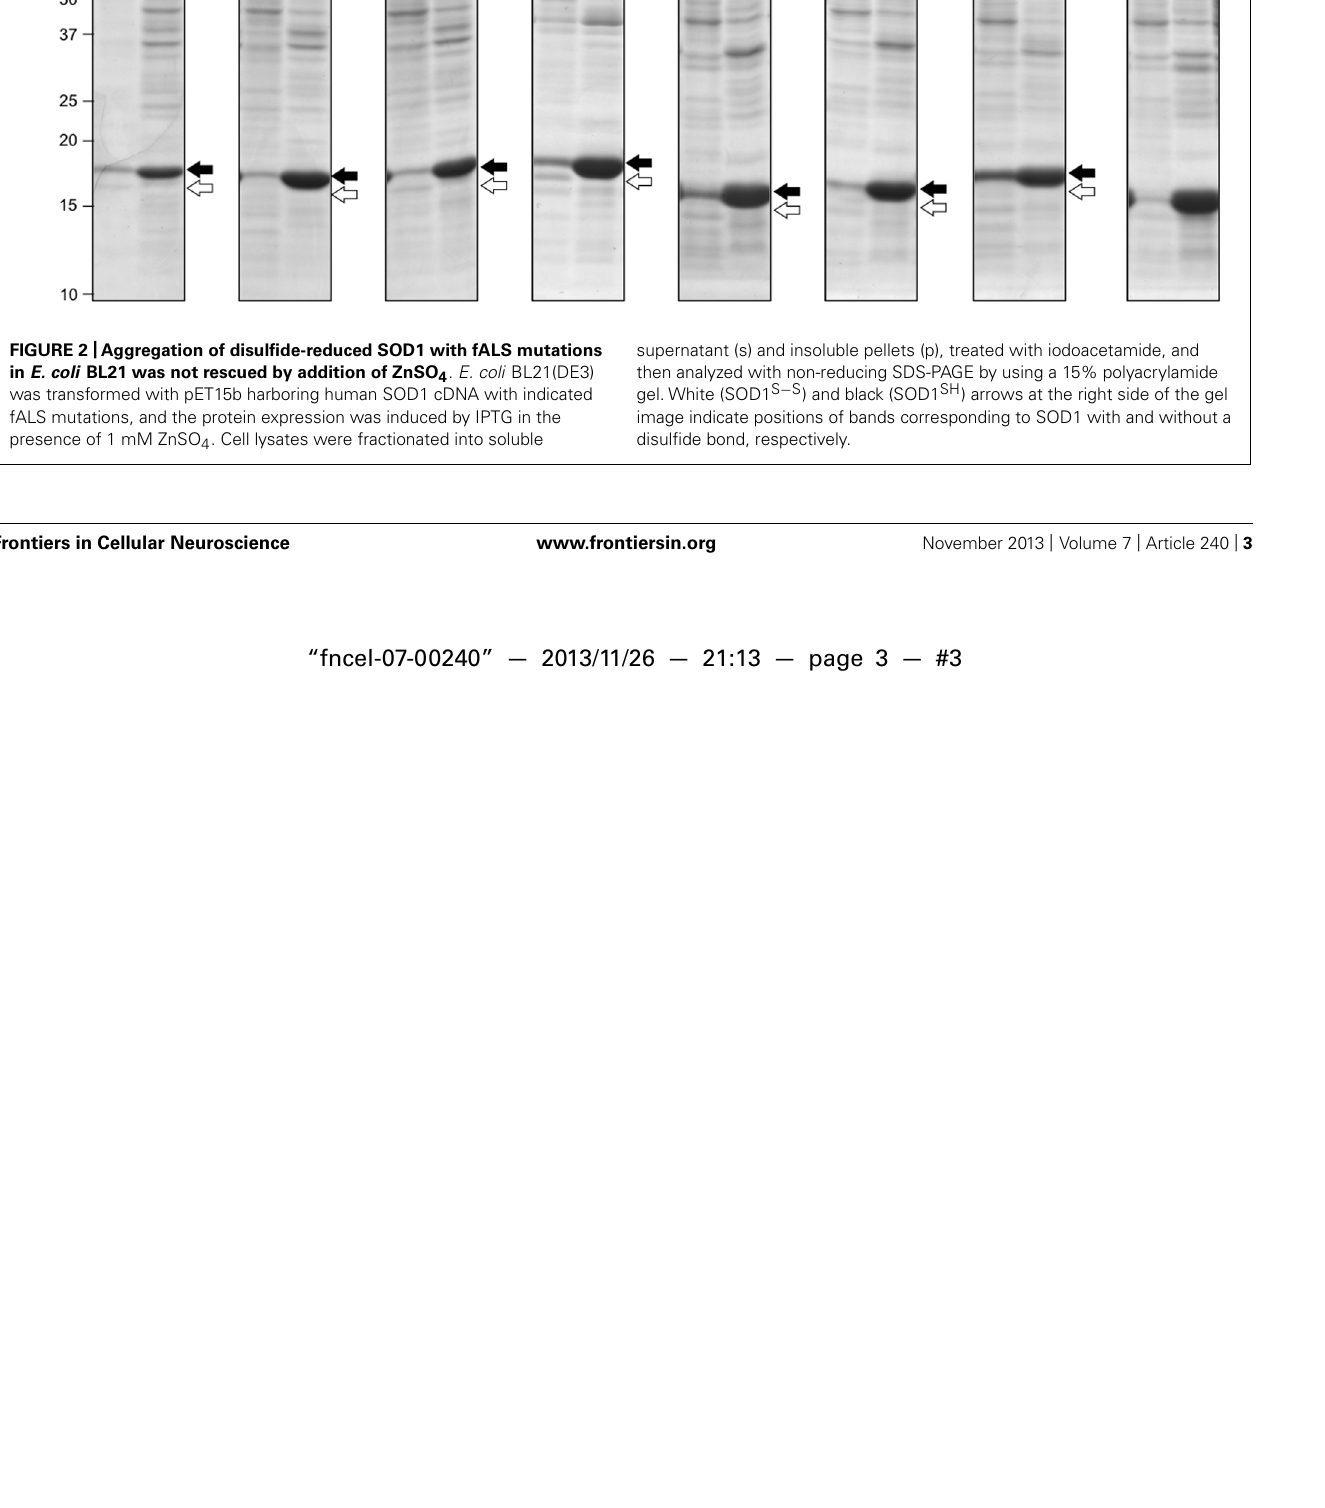
FIGURE 2 |Aggregation of disulfide-reduced SOD1 with fALS mutations in E. coli BL21 was not rescued by addition of ZnSO 4 . E. coli BL21(DE3) was transformed with pET15b harboring human SOD1 cDNA with indicated fALS mutations, and the protein expression was induced by IPTG in the presence of 1 mM ZnSO 4 . Cell lysates were fractionated into soluble